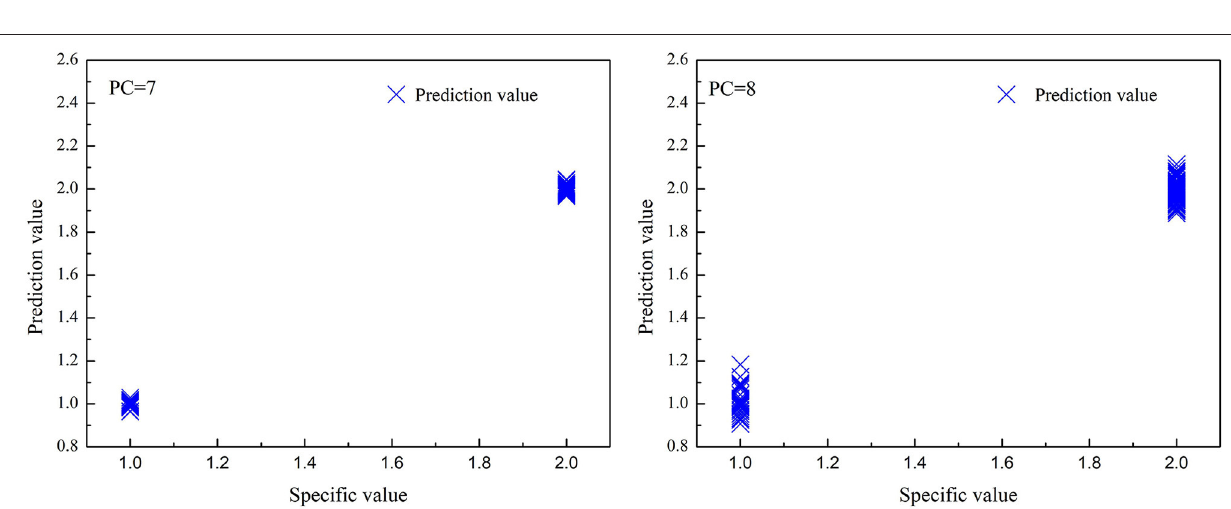
FIGURE 4 | The correlations between predicted value and specified value for principal component regression (PCR) models in the prediction set. (left): high deuteration rate (20–60%) fibers and protonic fibers; (right): high and low deuteration rate (1–60%) fibers and protonic fibers.